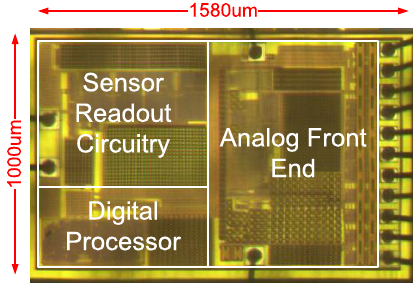
Figure 8. Die photo of the proposed sensor chip.